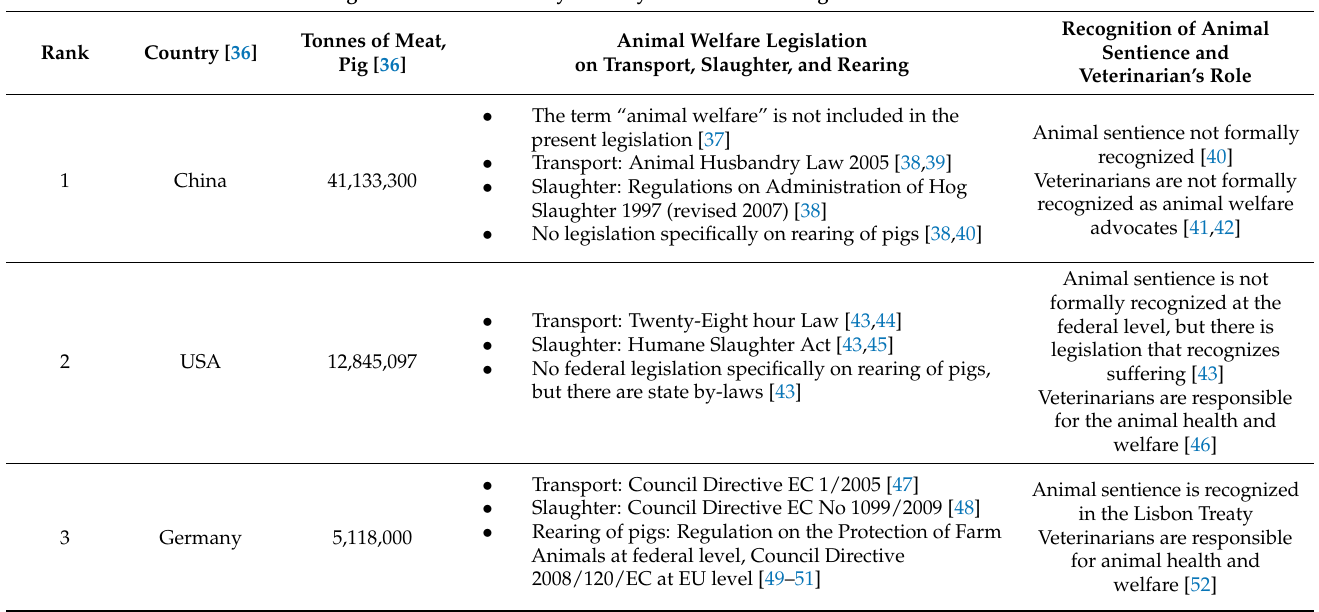
Table 1. Variations in approaches to animal welfare legislation and recognition of animal sentience for the top three pork-producing countries,